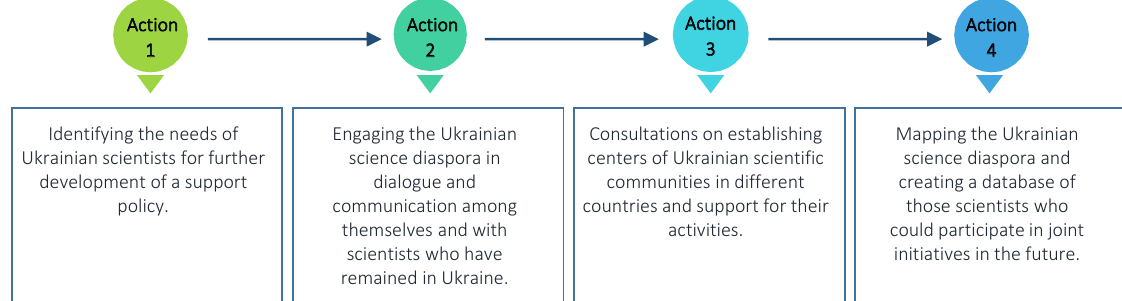
Figure 2. Activity plan of the “Ukrainian Science Diaspora”